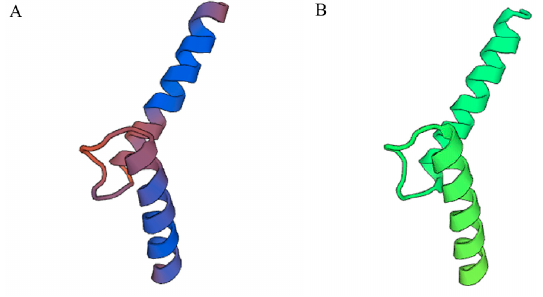
Figure 4. Three-dimensional structure prediction of PnbHLH1 ( A ) and MYC2 ( B ) proteins. 2.3. Electrophoretic Mobility Shift Assay Experiment of PnbHLH1 and Cis-Acting Element E-box Electrophoretic mobility shift assay (EMSA) in vitro can objectively and effectively reflect the potential of the interaction between the target protein and nucleic acid. Bacteriophage DE3 -solubilized BL21 ( DE3 )-specific strains were engineered on the basis of the BL21 strain for integrating the T7 RNA polymerase gene into the bacterial genome. The recombinant pET-28a-PnbHLH1 vector was transformed into BL21 ( DE3 ) for expression. After removal of the labeled protein, the size of the band was consistent with the predicted molecular weight of the PnbHLH1 protein which was 36 kD, indicating that the pET-28a-PnbHLH1 recombinant plasmid was stably expressed when the induction treatment was carried out at 4 h and 5 h by isopropy- β - D -thiogalactoside (IPTG) in the BL21 ( DE3 ) strain (Figure 5).